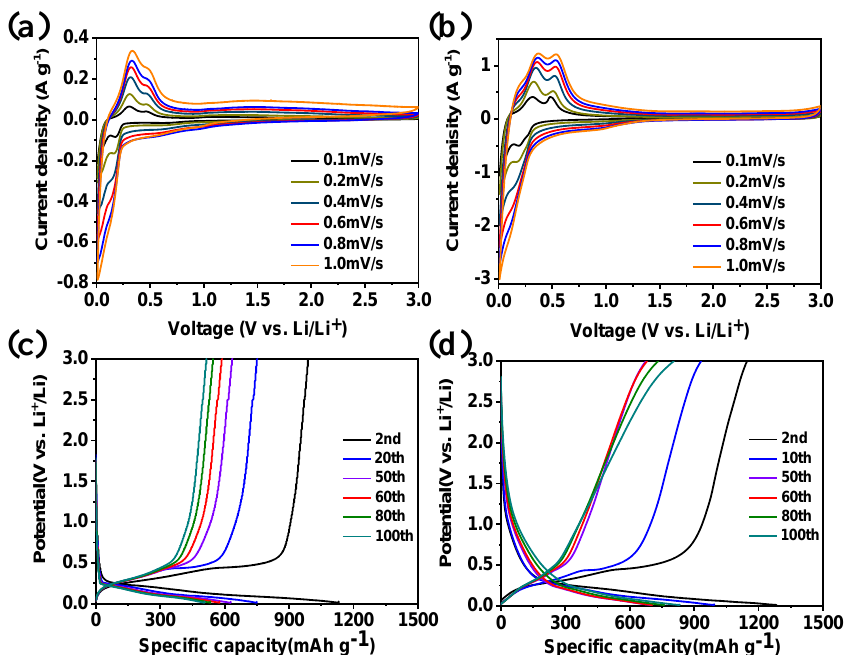
Figure 3. ( a ) CV curve of 50 nm Si at different scanning speeds. ( b ) CV curve of 50 nm Si-CNTs at different scanning speeds. ( c ) Charge and discharge curves of 50 nm Si electrode at different cycling number. ( d ) Charge and discharge curves of 50 nm Si-CNT electrodes at different cycling numbers.